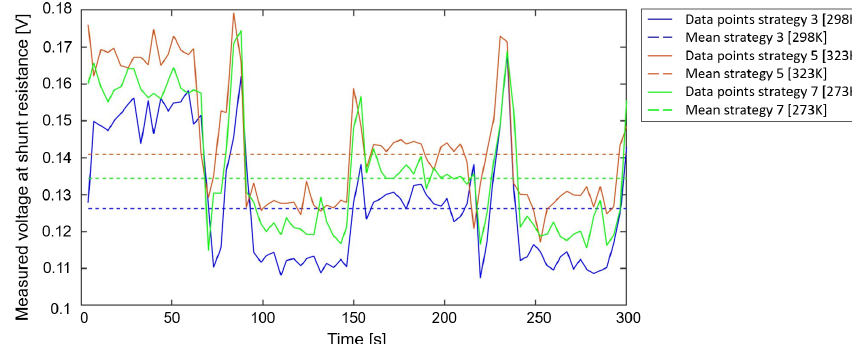
and 7. To optimize readability the dataset is reduced to 300